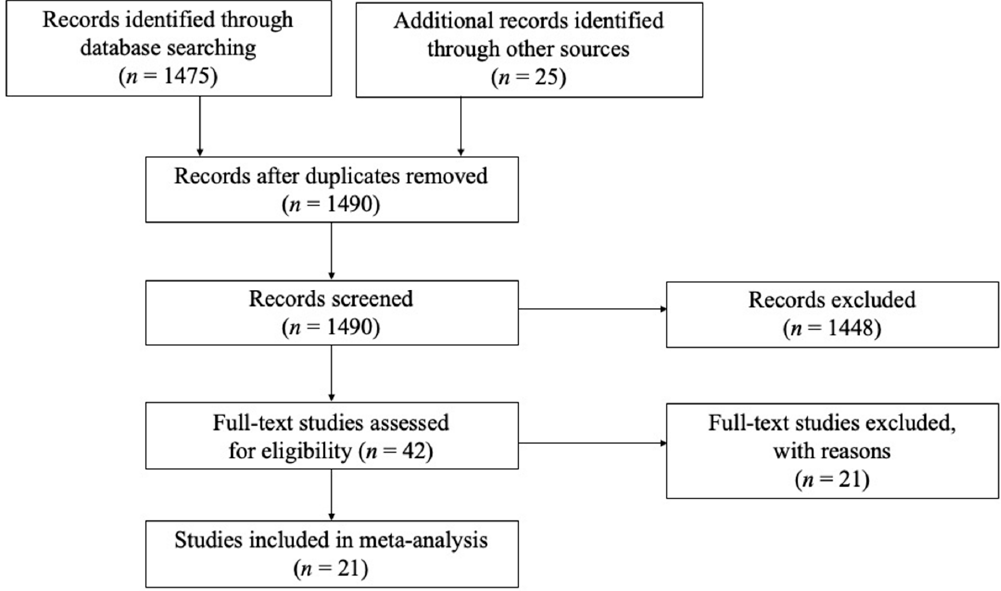
Figure 2. Flowchart outlining the study selection process.